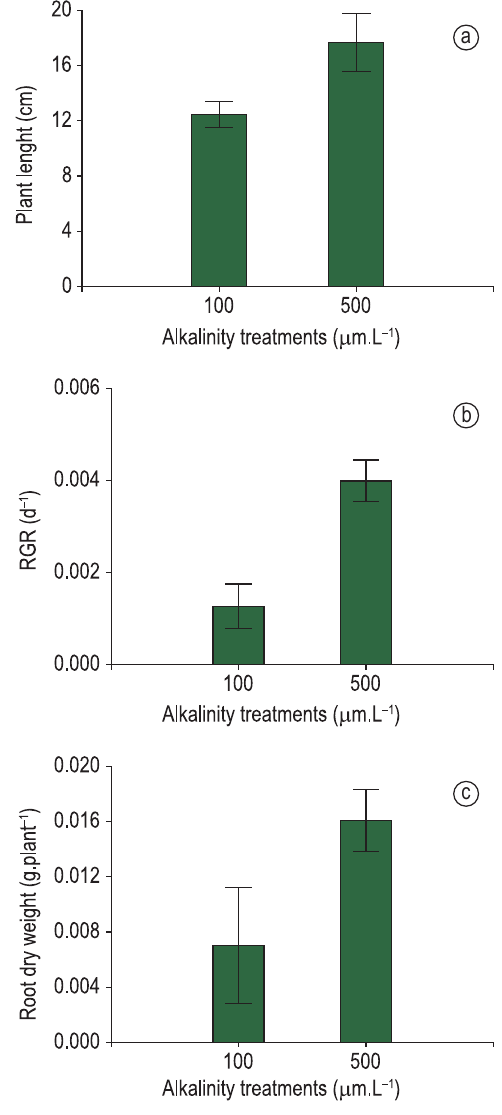
Figure 3. Mean values (±SD) of Egeria densa length (a), above-ground relative growth rates (b) and root dry weight (c) after 21 days growing in low (100 µM.L -1 ) and high (500 µM.L -1 )